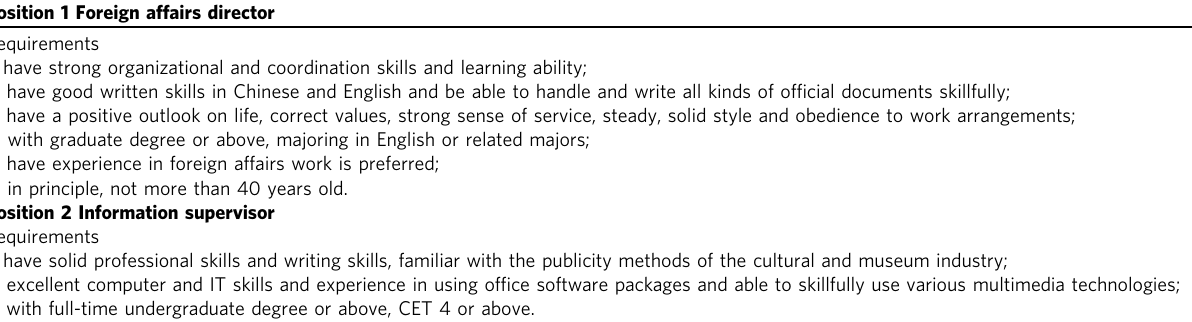
Table 5 Excerpt from job offer on ICOM China website (ICOM China,